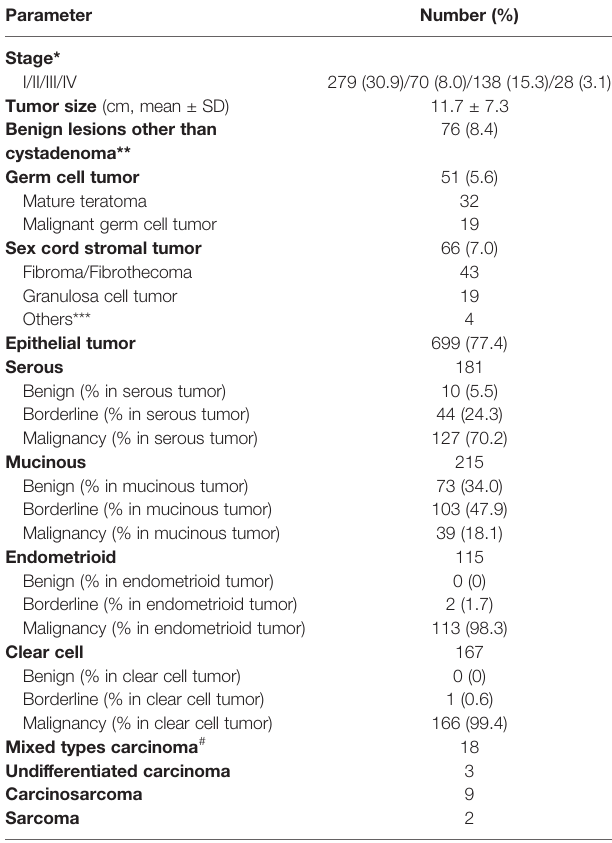
TABLE 2 | Final paraf fi n pathologic characteristics of the 903 ovarian tumors.